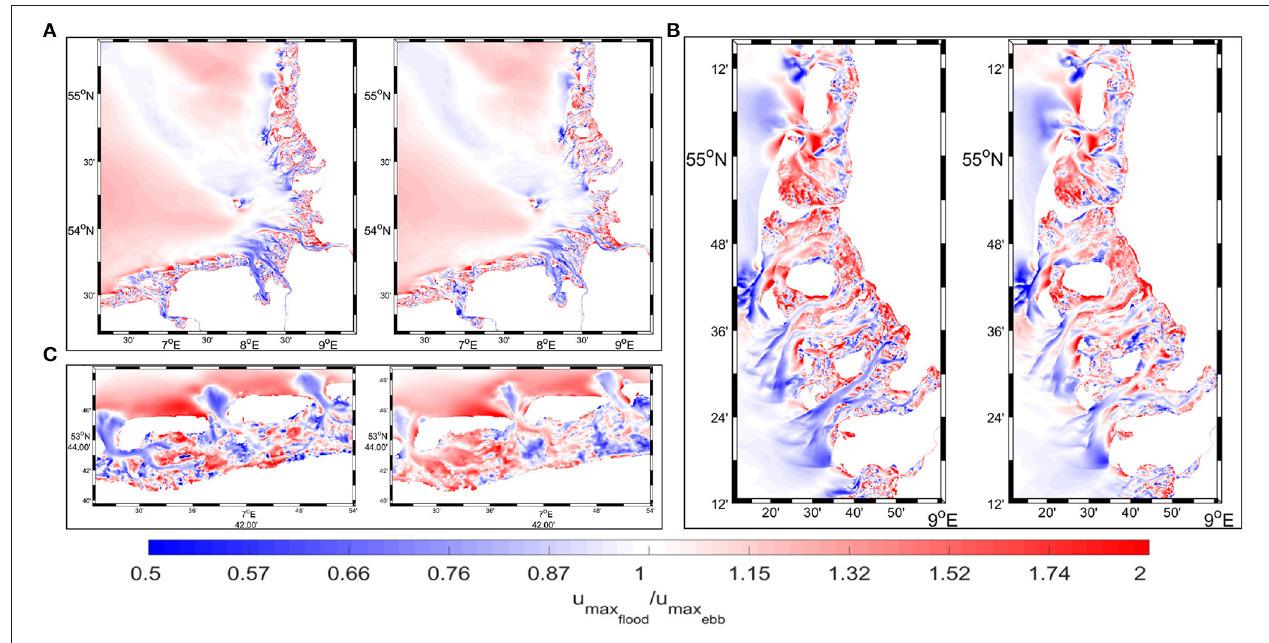
FIGURE 9 | Ratio between the maximum flood and ebb velocities in the German Bight (A) and magnified views of the NFWS (B) and EFWS (C) . The 1982 situation is shown on the left; the 2012 situation is shown on the